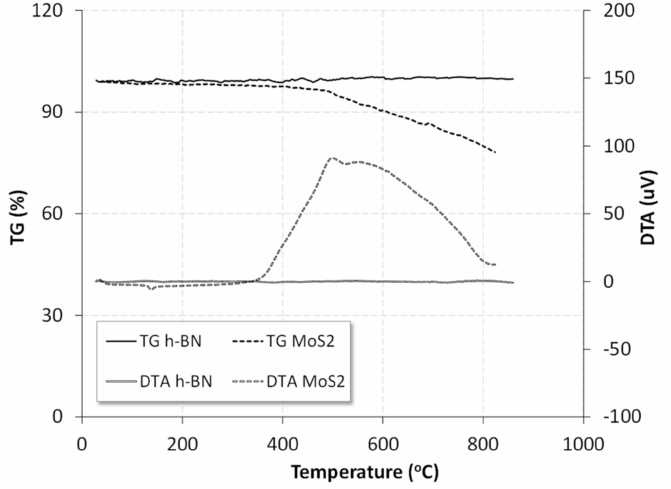
Figure 5. Thermogravimetric and Differential Thermal Analysis (TG-DTA) analysis of the employed lubricants: MoS 2 and